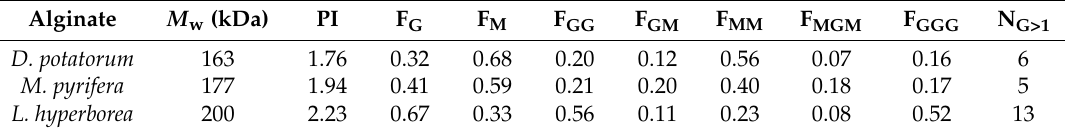
Table 1. M w and sequence parameters in alginates used in this study [20] 1